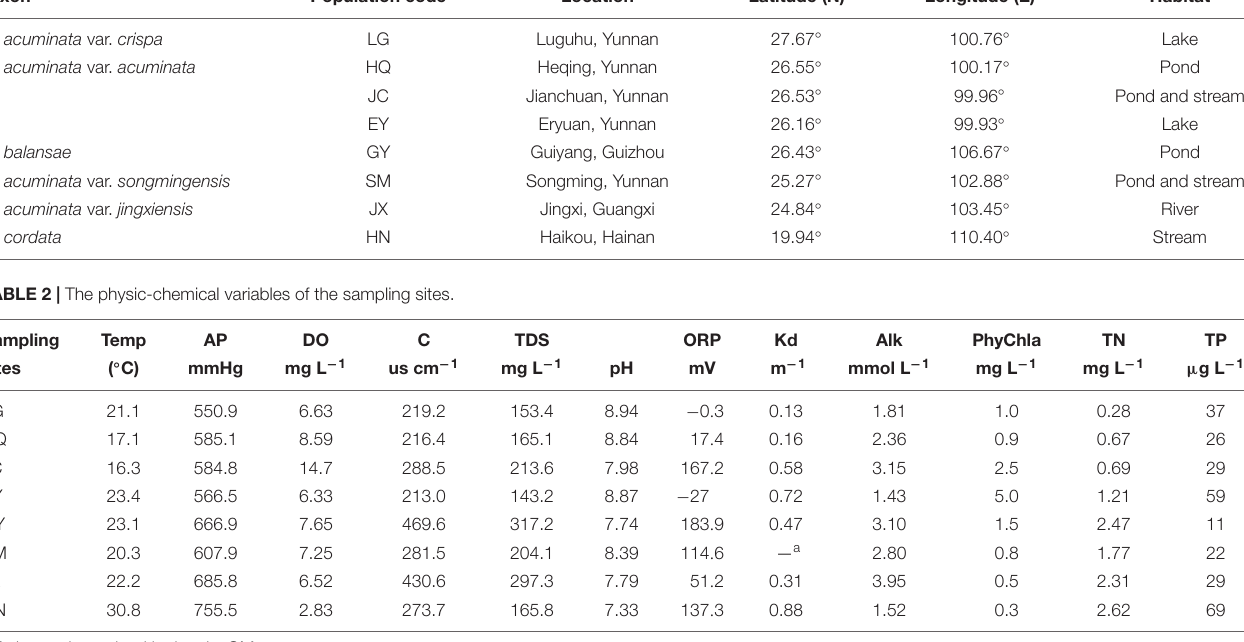
TABLE 1 | The geographic information of the sampling sites. Taxon